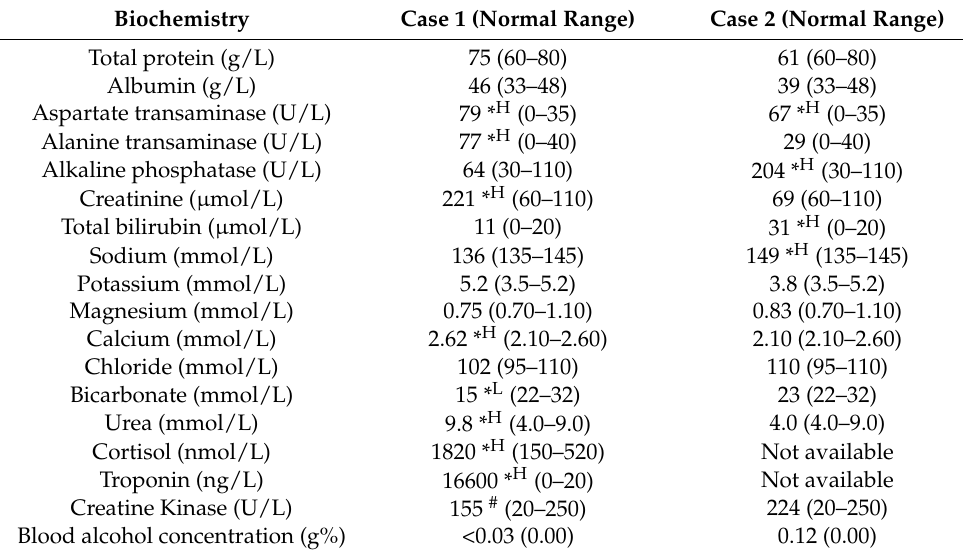
Table 2. Biochemistry findings at the time of